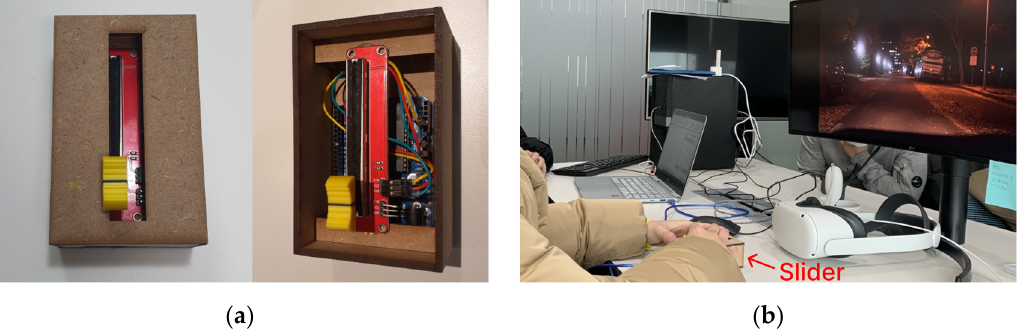
Figure 4. Test settings: ( a ) The input device—a continuous slider used to receive driver feedback to a sudden pedestrian stepping in; ( b ) Participant using the slider while watching the video in the lab.